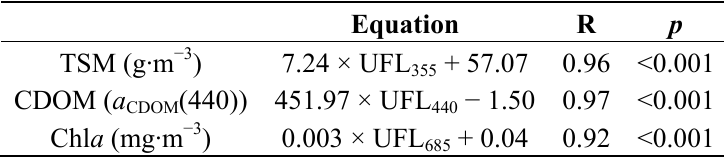
Table 3. Results of laboratory tank UFL measurement calibration with coinciding samples; model equations, Pearson moment correlation coefficient and p-values for TSM, CDOM and chl a